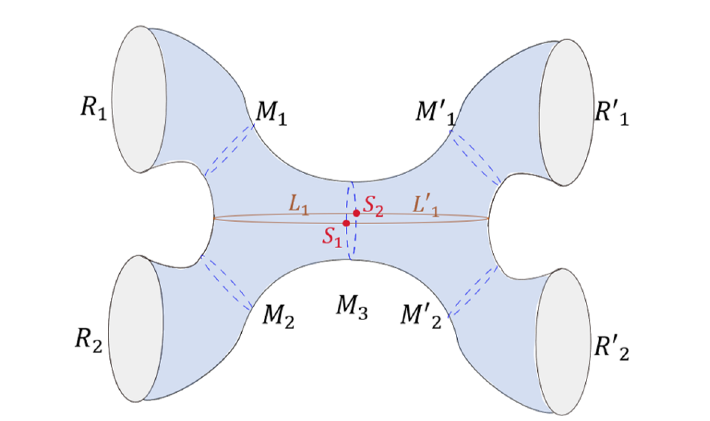
Figure 10 . The purification of R 1 and R 2 when removing the right hand side of M 3 . The cross section L 1 ∪ L 0 is the same type as in figure 2. We use a blue shadow to emphasize that this part is 1 in the inception geometry with a different Newton’s constant and a different AdS radius (compared with the original geometry).